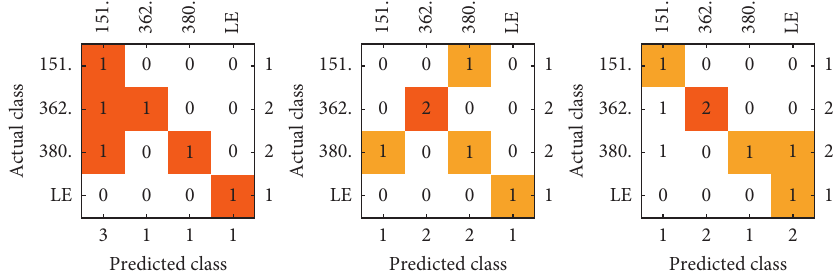
Figure 11: The 3 random confusion matrices obtained by random selection of train and test sets.